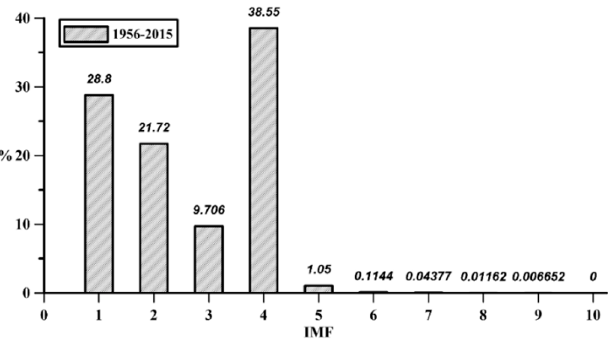
Figure 9. Weight of each IMF for a 60-year flow. Table 3. Results of 60-year data by EMD with energy and period.